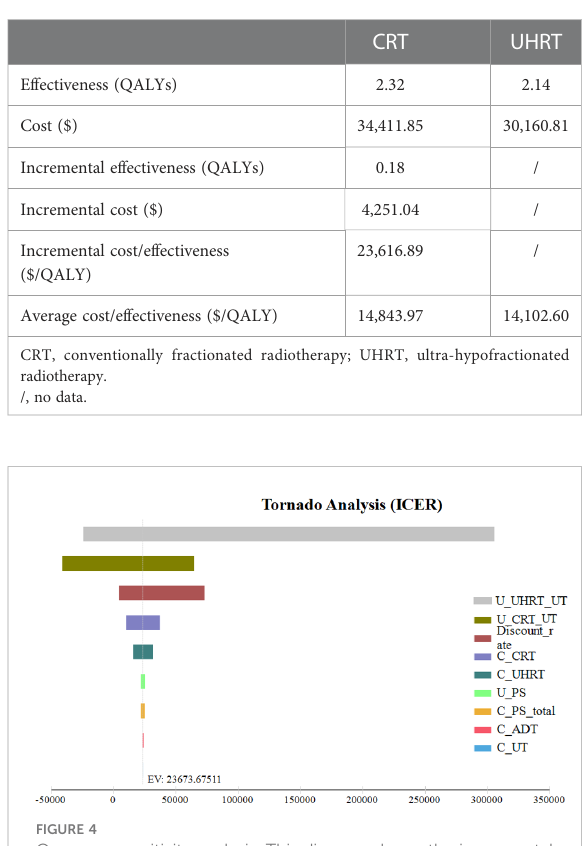
TABLE 4 Cost-effectiveness analysis of CRT and UHRT.